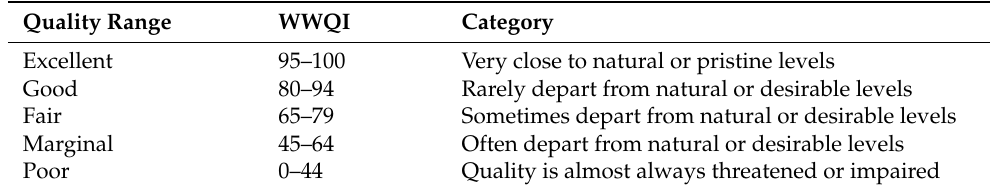
Table 2. Wastewater quality category based on CCME